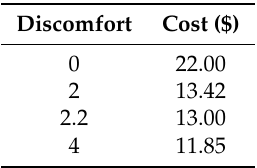
Table 7. Performance